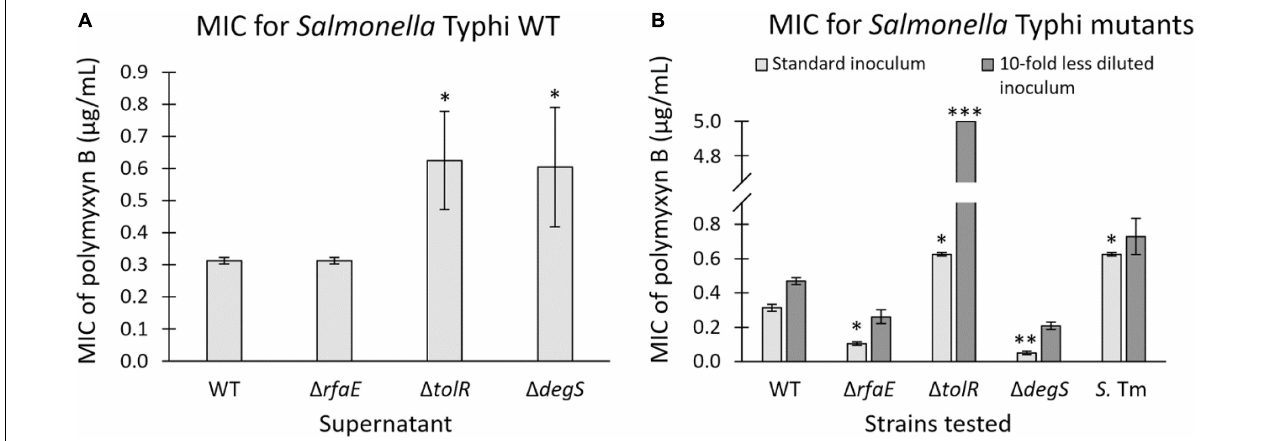
FIGURE 5 | (A) MIC of polymyxin B for S. Typhi WT in the presence of supernatant (1:20 v/v) of S. Typhi WT, (cid:49) rfaE , (cid:49) tolR, or (cid:49) degS . Supernatants were obtained from bacteria grown in LB at 37 ◦ C with shaking (OD 600 : 1.0–1.3). ( n = at least 4). (B) MIC of polymyxin B of strains S. Typhi WT, (cid:49) rfaE , (cid:49) tolR or (cid:49) degS , and